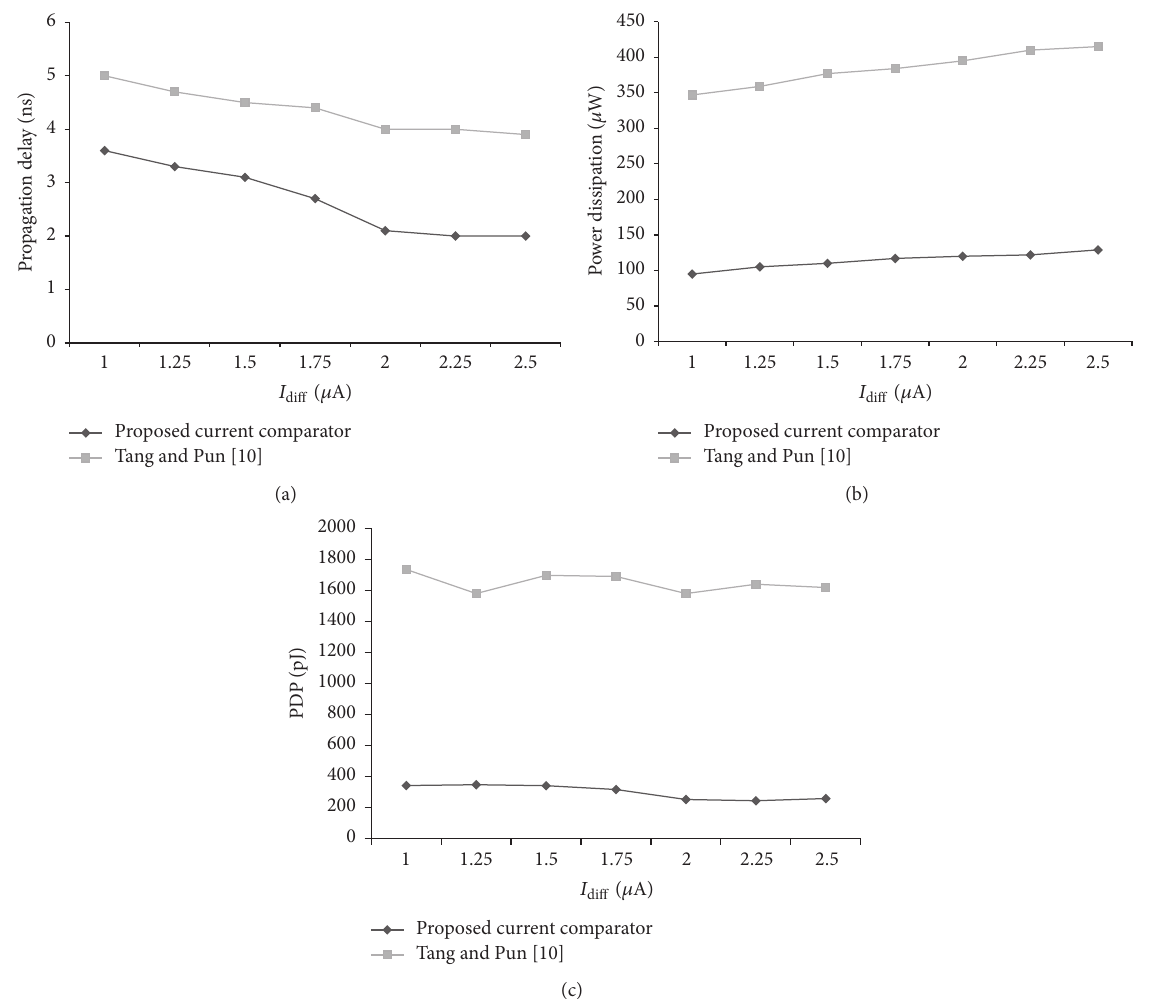
Figure 5: Variation of (a) delay, (b) power dissipation, and (c) power delay product versus current difference.